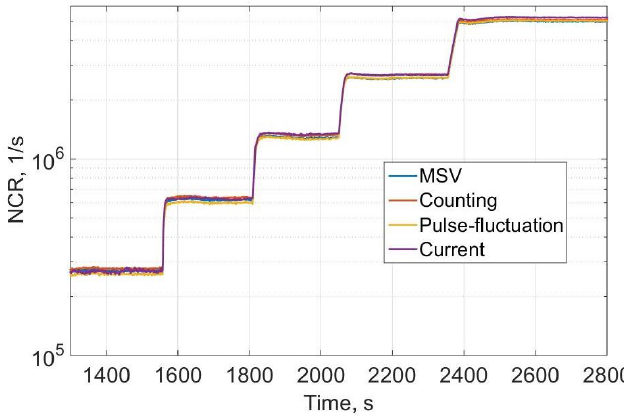
Fig. 5. Normalized count rates of the DAQ measuring chains in the tested range.